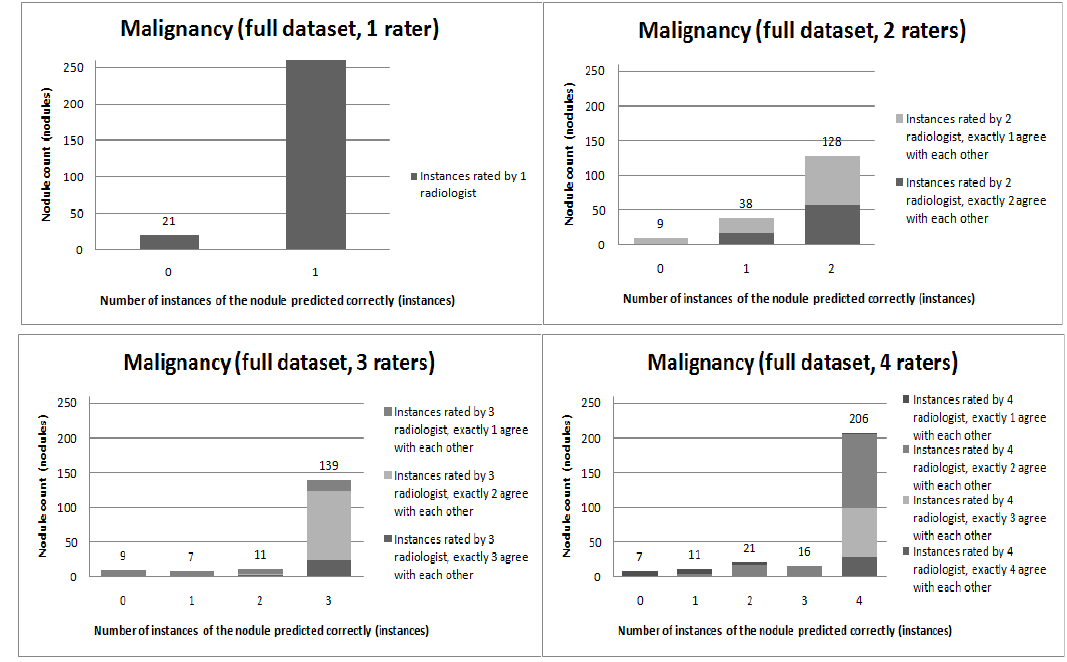
Figure 7. Visual overview of the ensemble of classifiers’ agreement with the panel of experts’ opinions